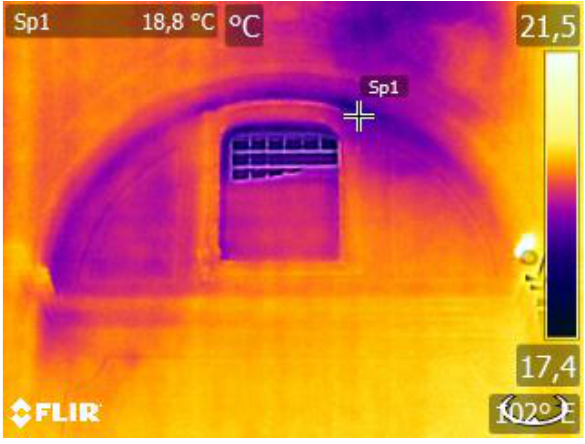
Figure 5. Moisture along the arch of the perimeter wall The thermal image, finally, shows an evident irregular temperature map with a humidity level of greater extension than that visible on the surface by photogrammetric survey. Moisture in the walls reduces the resistance to heat transmission, depending on the amount of water retained, resulting in lower temperatures.